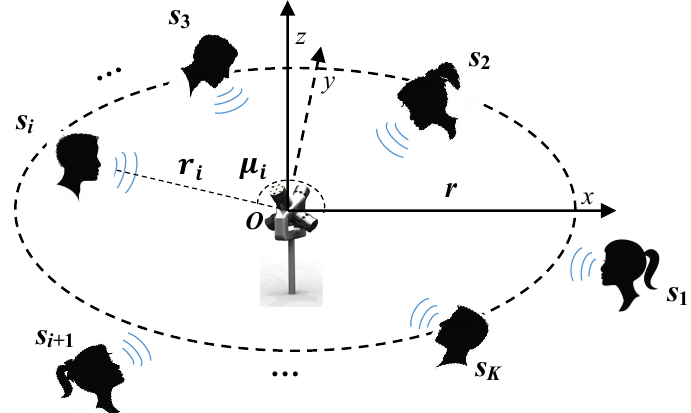
Figure 1. Illustration of the multi-source model and configuration of recording scene. The surrounding sources are numbered S 1 to S K